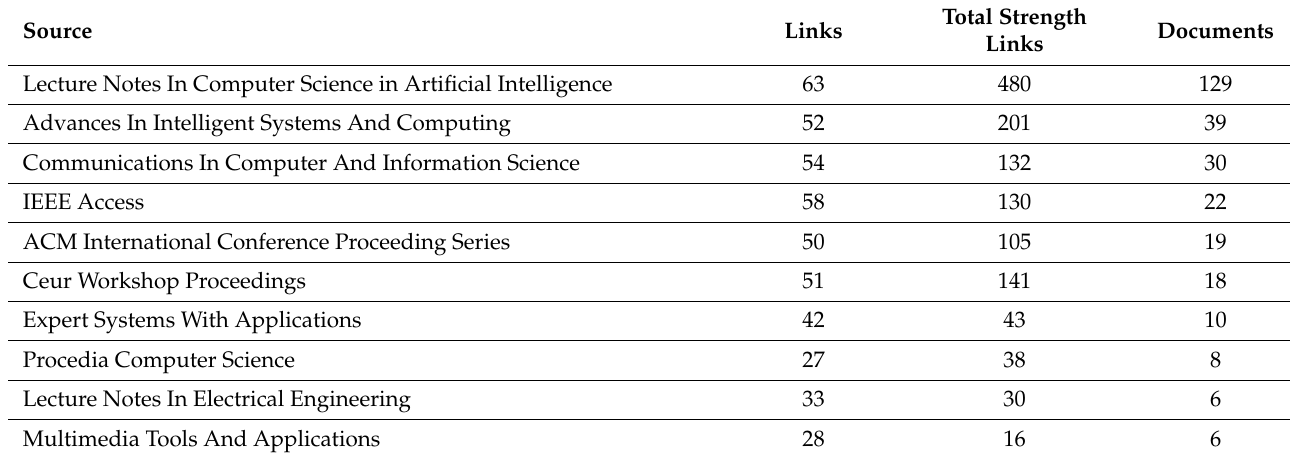
Total Strength Links